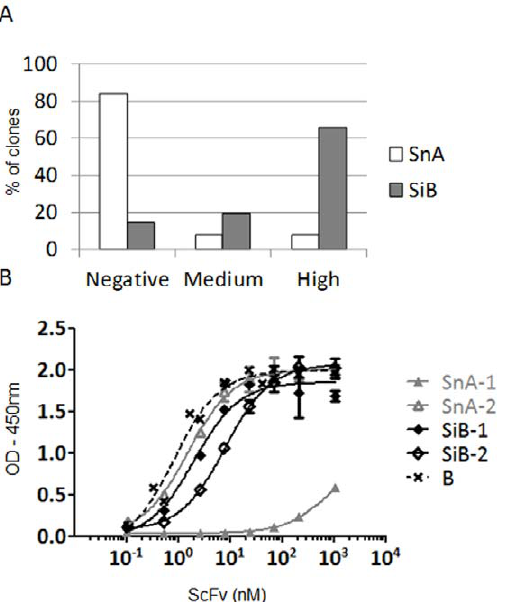
Figure 5. Screening of selections outputs from biased and naive synthetic libraries. (A) The supernatants of random clones from the selection round 3 against hIFN c were tested independently in scFv ELISA against the same target (88 clones tested for each library). Clones were then ranked according to their level of absorbance at 450 nm. Were defined ‘‘high’’, clones with absorbance values above 70% of the signal of a positive control scFv (absorbance , 1.8), ‘‘medium’’, clones between 10% and 70% (absorbance between 0.3 and 1.8) and ‘‘negative’’, clones below 10%. Histograms show the percentage of clones relative to their corresponding level of absorbance. (B) The two most frequent binders according to NGS were purified as scFv and tested in parallel in a dose response ELISA against hIFN c (n=2). Sequences from these clones are given in Table 3. The graph shows the level of absorbance at 450 nm in function of scFv concentration in nM. B is a positive control.